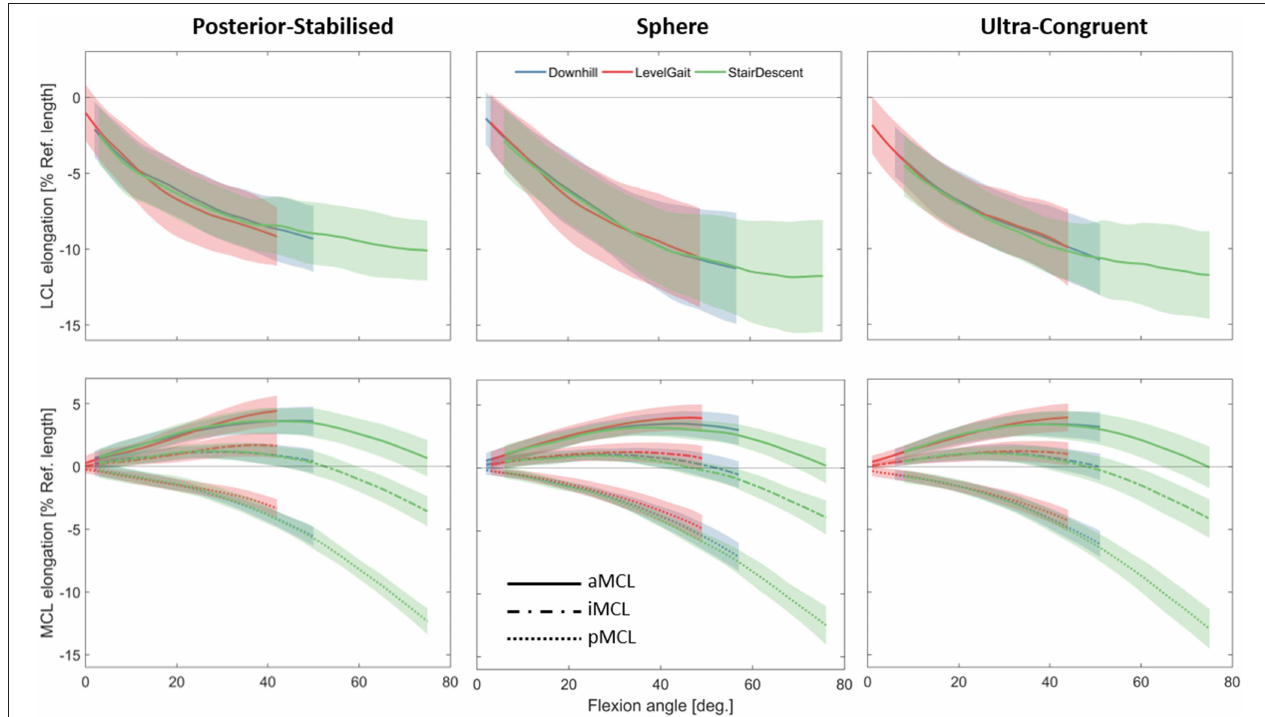
FIGURE 6 | Average elongation of the LCL (top) and MCL (bottom) during five repetitions of the three studied activities plotted against the knee flexion angle. Average elongations were calculated only over the flexion ranges achieved by all the subjects during all the trials. Solid lines represent inter-subject means and shadings represent ±